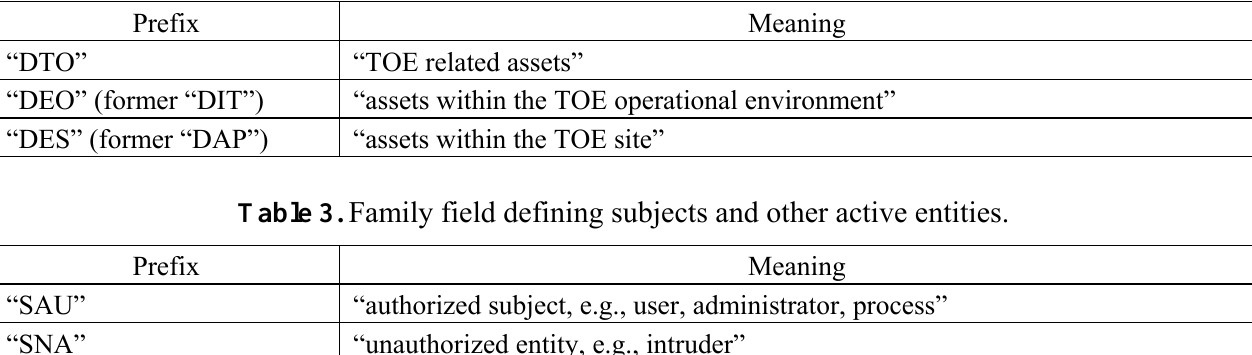
Table 2. Family field defining assets and other passive entities.